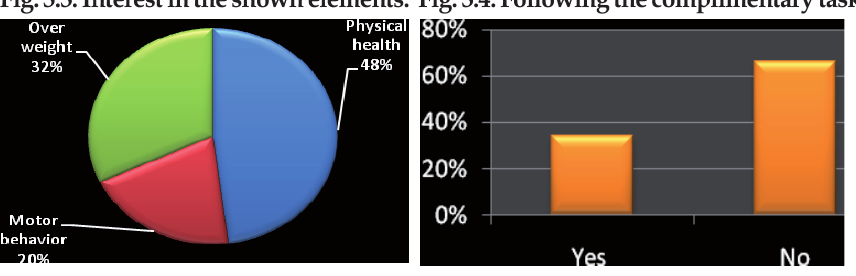
Fig. 3.3. Interest in the shown elements. Fig. 3.4. Following the complimentary tasks.